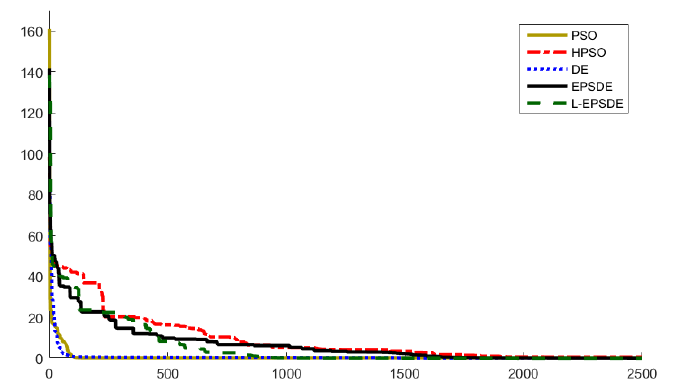
Figure 19. Convergence rate of the five metaheuristic methods for Case 4.